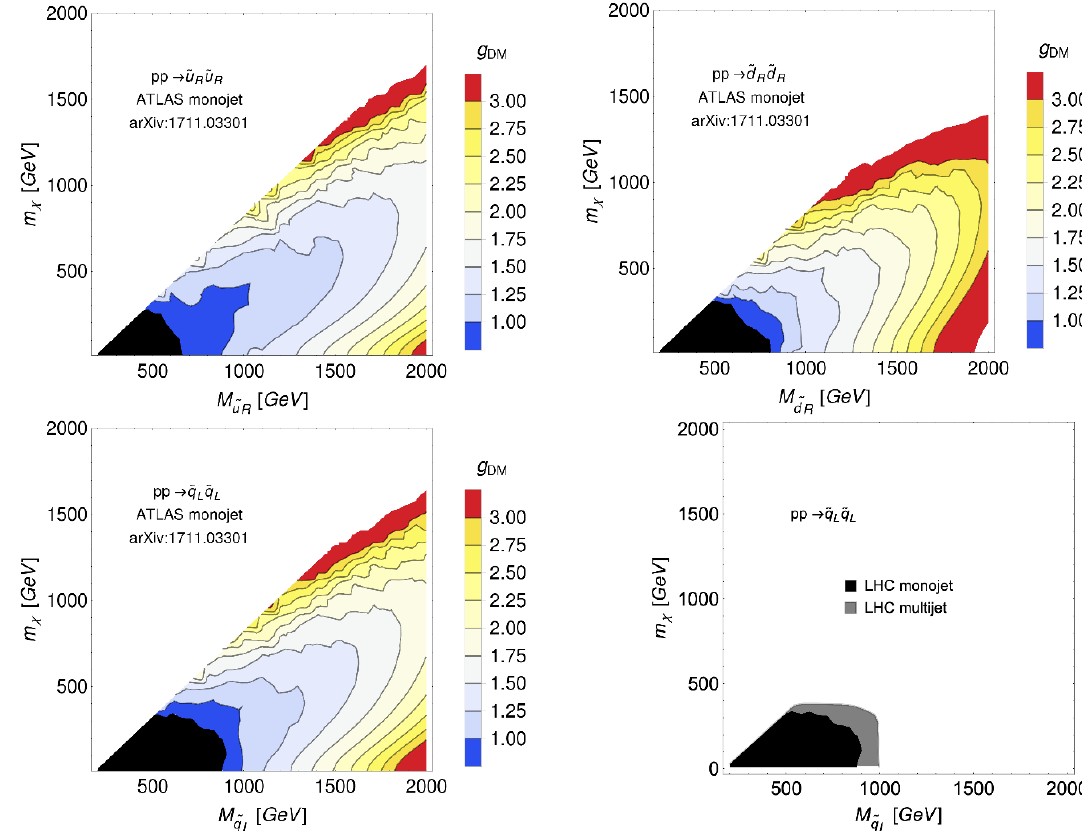
Figure 12 . ATLAS monojet constraints on g DM derived from mediator pair production for the u R (upper left), d R (upper right) and q L (lower left) models. Despite the moniker \mono-jet", this search does not veto sub-leading jets, and is thus sensitive to =E T plus one, two, or three jet topologies. In the lower right panel, LHC monojet and multijet constraints for the q L model are compared. The black and grey regions correspond to exclusion independent of the value of g DM for the two di(cid:11)erent experimental analyses, as